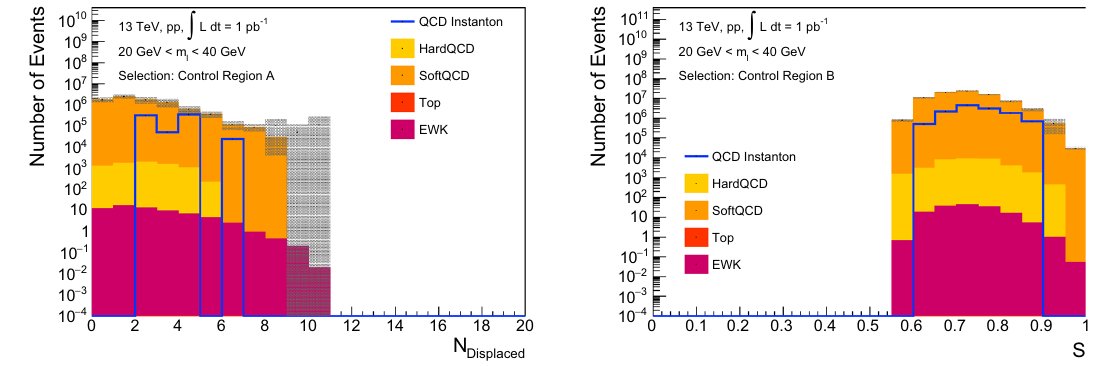
Fig. 12 Predicted distributions of the number of displaced tracks in the control region A (left) and the event sphericity in control region B (right),weightedbytheirpredictedcrosssectionsforanintegratedlumi- (cid:8) nosityof L = 1pb − 1 .Theinvariantmassofallreconstructedtracksis